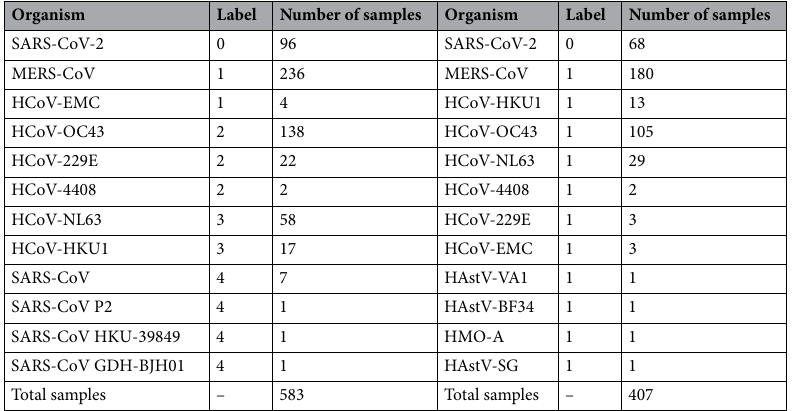
Table 3. Organism, assigned label, and number of samples in the unique sequences for the NGDC repository (left) and query: gene = “ORF1ab” AND host = “homo sapiens” AND “complete genome” in the NCBI repository (right). We use the NCBI organism naming convention 44